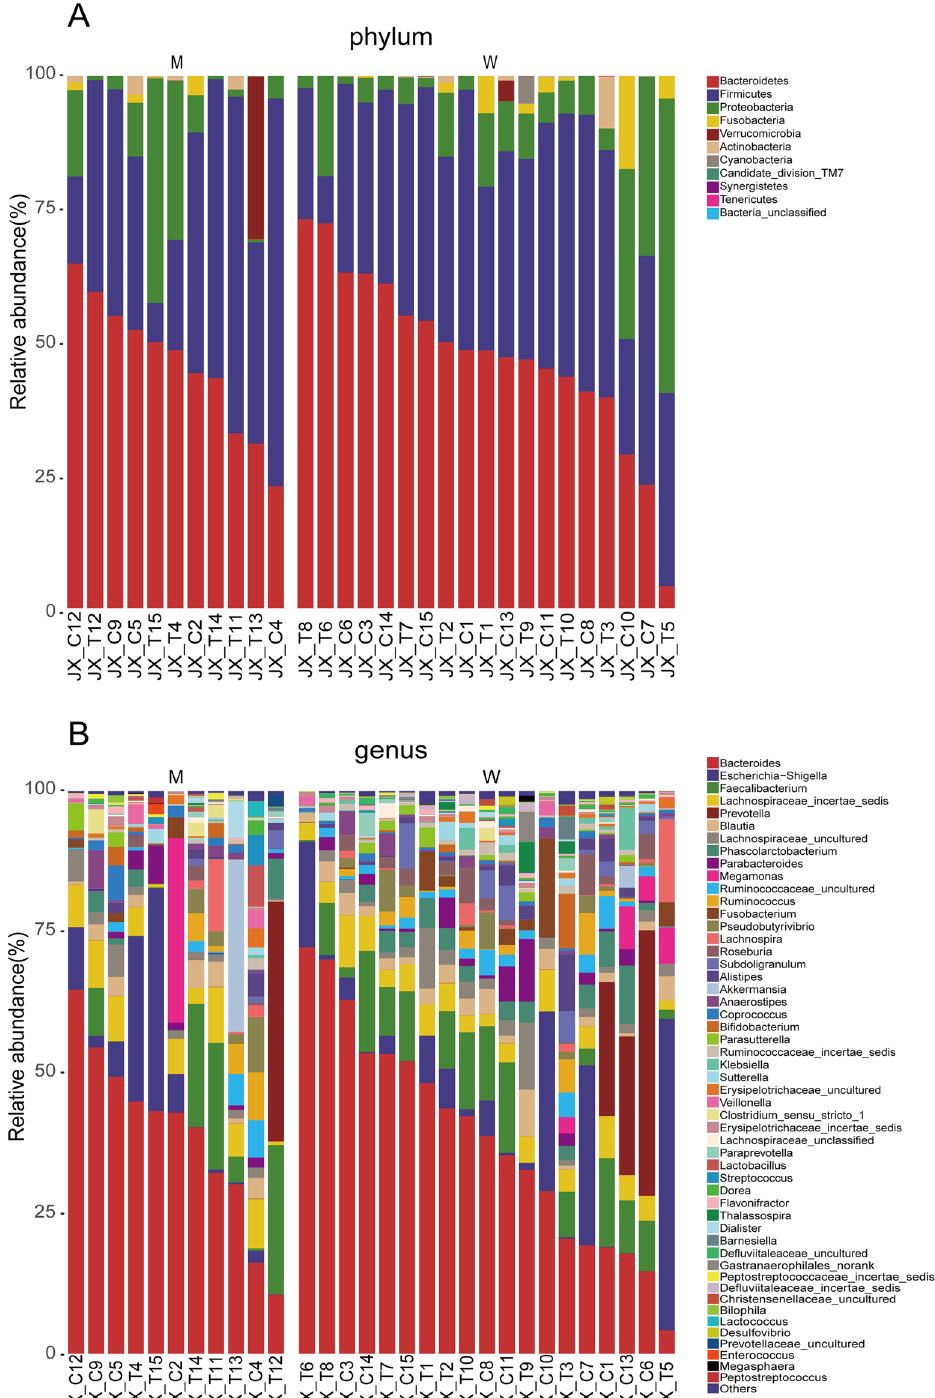
Figure 1. Phylogenetic profiles of the fecal microbiota between the M and W groups of the CAPD patients. ( A ): phylum level; ( B ): genus level. CAPD continuance ambulatory peritoneal dialysis, W well-nourished group, M malnourished group. (Fig. 1 was produced by the R Project for Statistical Computing (r-project.org) using the Grammar of Graphics ggplot2 (tidyverse.org) 44